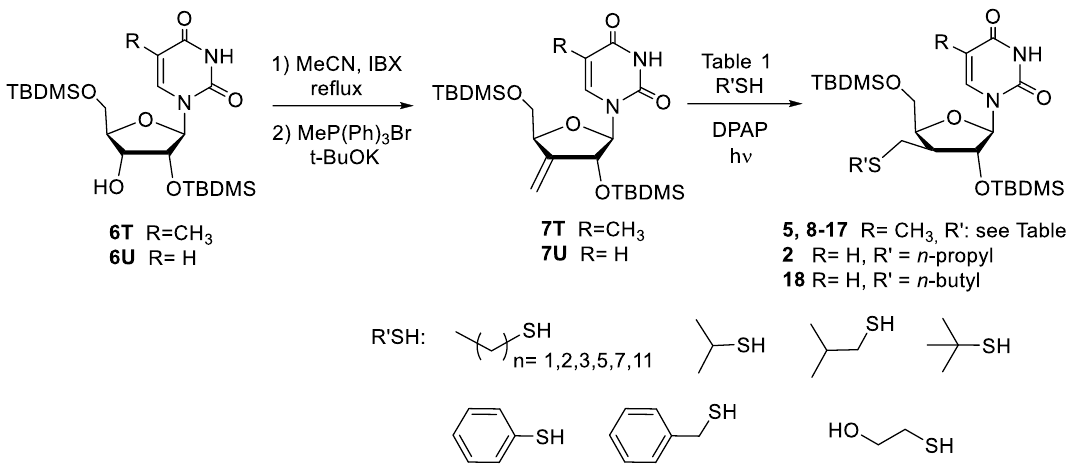
Figure 2. Cytotoxic effects of the previously prepared 3’ -deoxy- 3’ -C- modified β - D -xylofuranosyl- uracil ( 1 and 2 ) and – thymine ( 3 – 5 ) derivatives [19] on squamous cell carcinoma (SCC) and human keratinocyte (HaCaT) cell lines. (TBDMS: tert -butyldimethylsilyl). The starting exomethylene derivatives 7T and 7U were synthesized by oxidation-methylenation